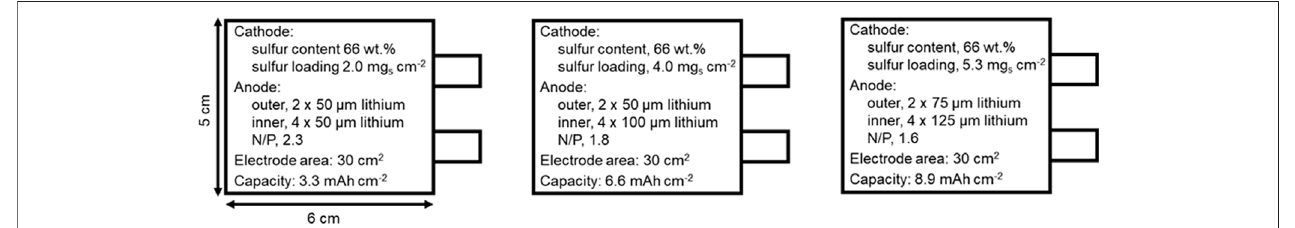
FIGURE 3 | Design parameters of the fabricated Li-S pouch cells.